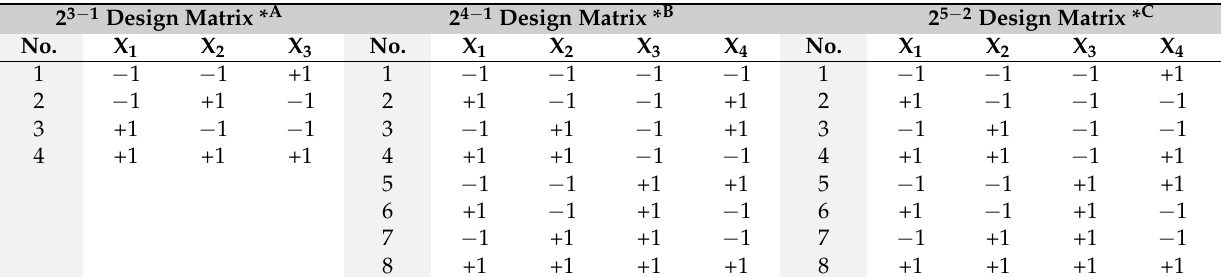
Table 5. Two-level fFD matrix for three (2 3 − 1 ), four (2 4 − 1 ), and five (2 5 − 2 ) experimental